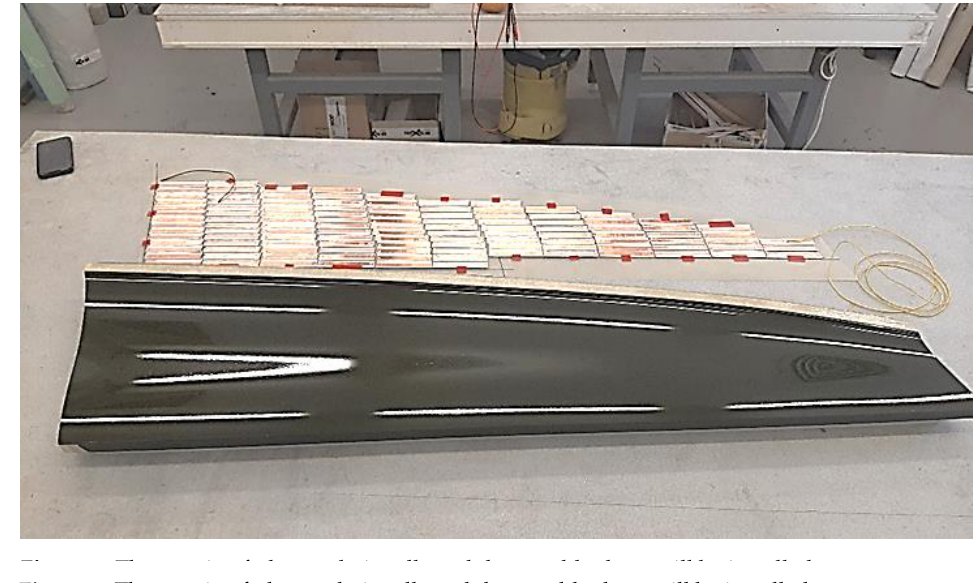
Figure 8. The matrix of photovoltaic cells and the mould where will be installed.